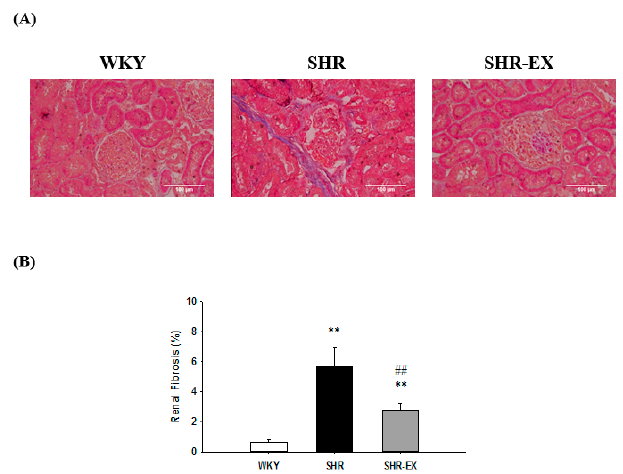
Figure 2. Representative histopathological analysis of kidney sections from the renal cortex in Wistar-Kyoto rats (WKY), sedentary spontaneously hypertensive rats (SHR), and spontaneously hypertensive rats with exercise training (SHR-EX). ( A ) Masson’s trichrome staining (fibrosis: stained blue). The images of the renal cortical architecture were magnified 400×; ( B ) the bar represents the percentage of the blue area to the field area in Masson’s trichrome staining and indicates mean values ± SD (n = 8 in each group). ** p < 0.01, denotes a significant difference from the WKY group. ## p < 0.01, denotes a significant difference between the SHR group and the SHR-EX group.